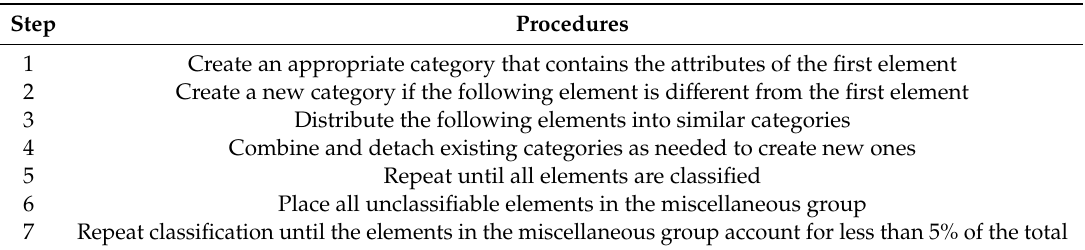
Table 3. The classification procedures of bootstrapping content